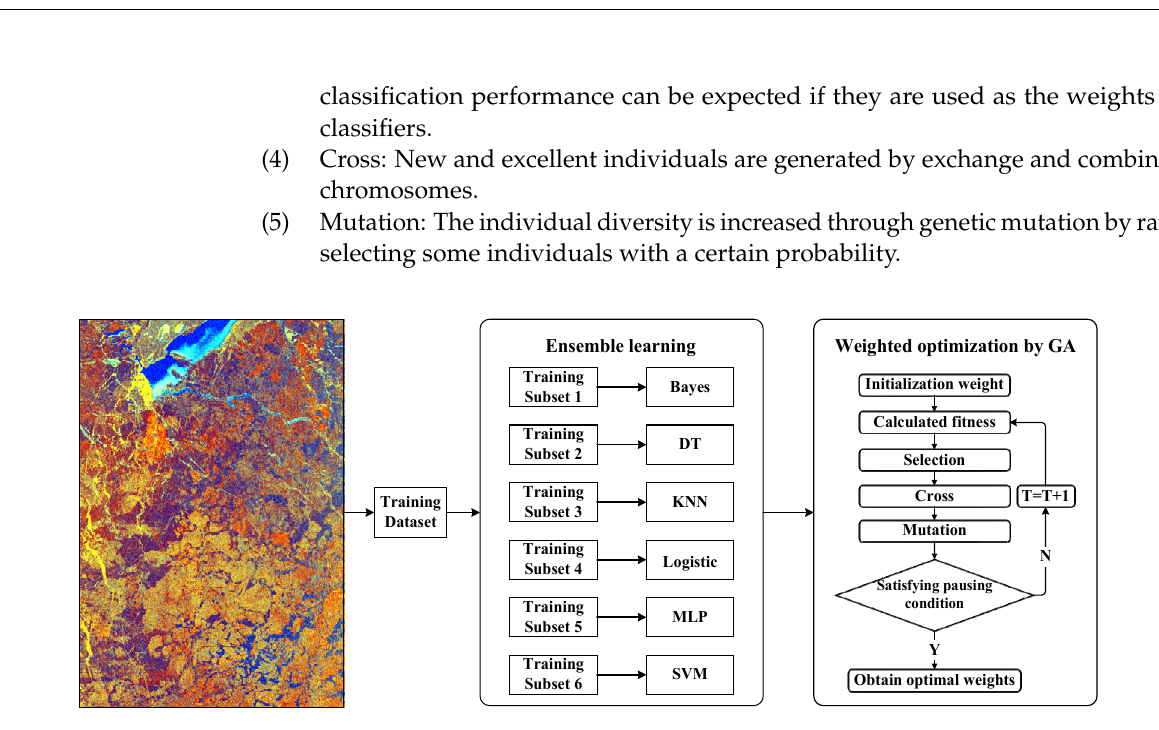
Figure 5. The weights of base classifiers optimized by a genetic algorithm.